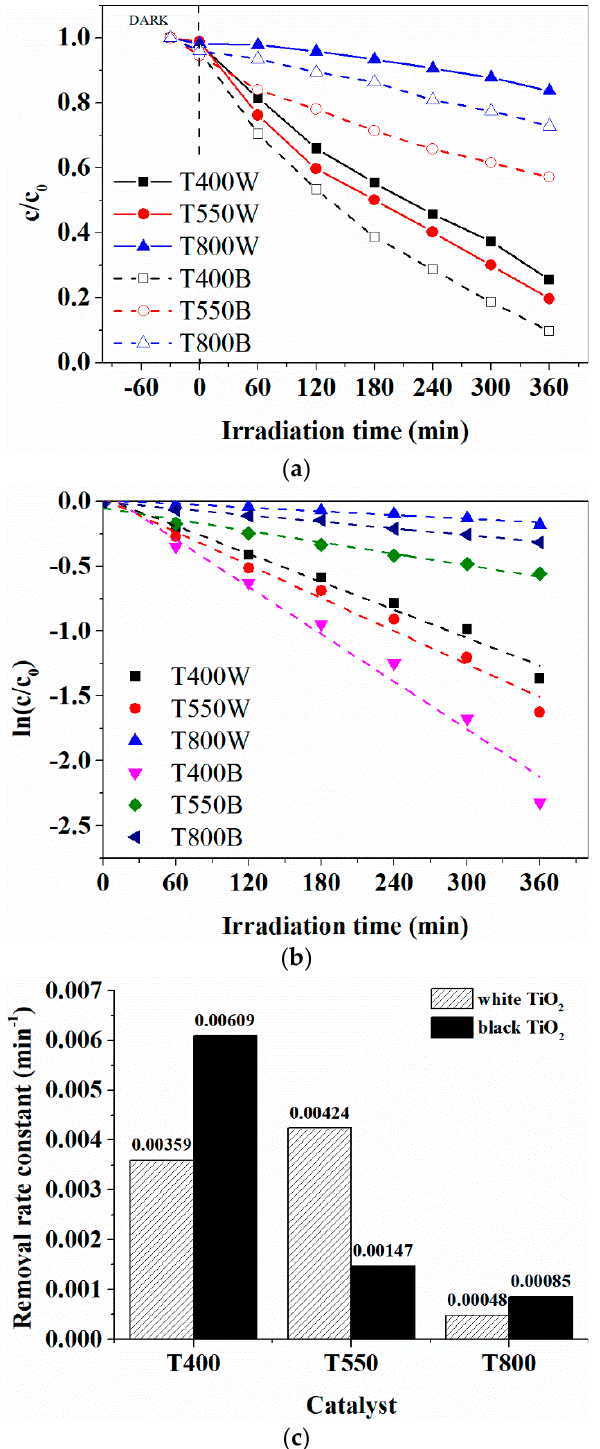
Figure 8. ( a ) Evaluation of the visible-light-driven photocatalytic activity of the original white TiO 2 and black TiO 2 prepared through NaBH 4 reduction. ( b ) A plot of ln(c/c 0 ) versus irradiation time for the photocatalytic degradation of amoxicillin at different catalysts. ( c ) First-order kinetics rate constant of amoxicillin removal by visible simulated irradiation over original white and black titanium oxide photocatalysts.